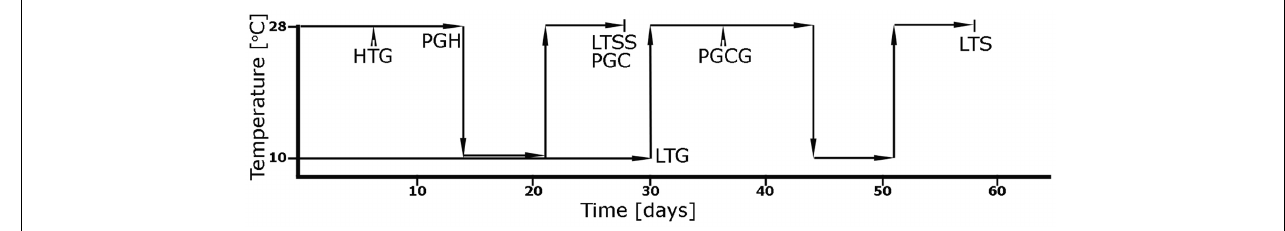
FIGURE 1 | Schematic diagram of temperature changes and growth periods used for the five chilling tolerance indices assessed in this study. Low Temperature Germinability (LTG): Mean percent germination of seeds after 30 days of incubation at 10 ± 1 ◦ C was normalized with the mean percent germination of seeds at 28 ± 1 ◦ C (high temperature germination index, HTG). Plumule Growth rate after Cold Germination (PGCG): After 30 days of germination at 10 ± 1 ◦ C, seeds were incubated at 28 ± 1 ◦ C for 4 days, and (mean plumule length at day 4 minus mean coleoptile length) was divided by 4. Low Temperature Seedling Survivability (LTSS): After 2 weeks of growth at 28 ± 1 ◦ C, healthy seedlings were incubated for 1 week at 10 ± 1 ◦ C, then again at 28 ± 1 ◦ C for 1 week of recovery growth, and (the mean number of green and healthy looking seedling after 1 week of recovery growth divided by the number of the initially healthy looking 2-week-old seedlings) was multiplied by 100. Plumule recovery Growth after Cold exposure (PGC): The mean leaf length of seedlings after 2 weeks of growth at 28 ± 1 ◦ C was recorded as the Plumule growth at High temperature (PGH) index, then again measured after incubation for 1 week at 10 ± 1 ◦ C and 1 week of recovery growth at 28 ± 1 ◦ C. The mean plumule length after 1 week of recovery growth was normalized by subtraction of PGH and division of that number by PGH and multiplied by 100. Low Temperature Survival (LTS): After 30 days of germination at 10 ± 1 ◦ C, seeds were incubated for 2 weeks at 28 ± 1 ◦ C followed by selection of healthy seedlings, which were incubated for 1 week at 10 ± 1 ◦ C, then for 1 week of recovery growth at 28 ± 1 ◦ C, and (the mean number of green and healthy looking seedling after 1 week of recovery growth divided by the number of the initially healthy looking 2-week-old seedlings) was multiplied by